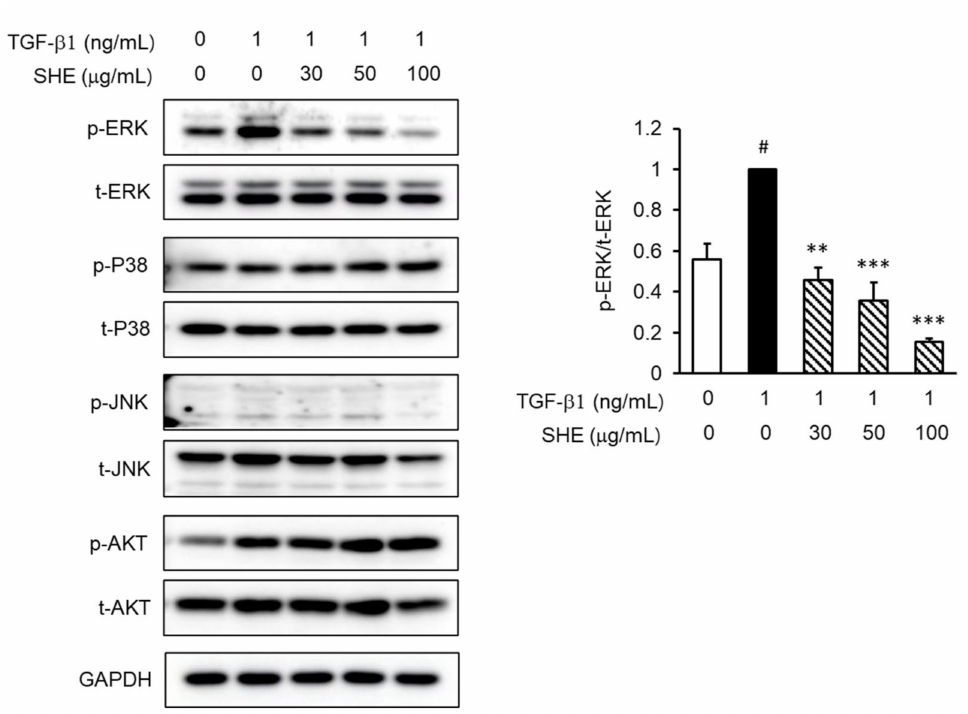
Figure 4. Effect of SHE on MAPK and PI3K/Akt phosphorylation in TGF- β 1-stimulated NPDFs. The cells were treated with the indicated SHE concentrations (30, 50, and 100 µ g/mL) for 1 h before stimulation with TGF- β 1 (1 ng/mL) for 15 min. Western blotting was then performed with antibodies specific for the phosphorylated form of MAPK and PI3K/Akt with cytosol protein extract. The results presented are representative of three independent experiments. Each bar represents the mean ± SEM ( n = 3) from three independent experiments. # p < 0.05 vs. control group (no treatment group);